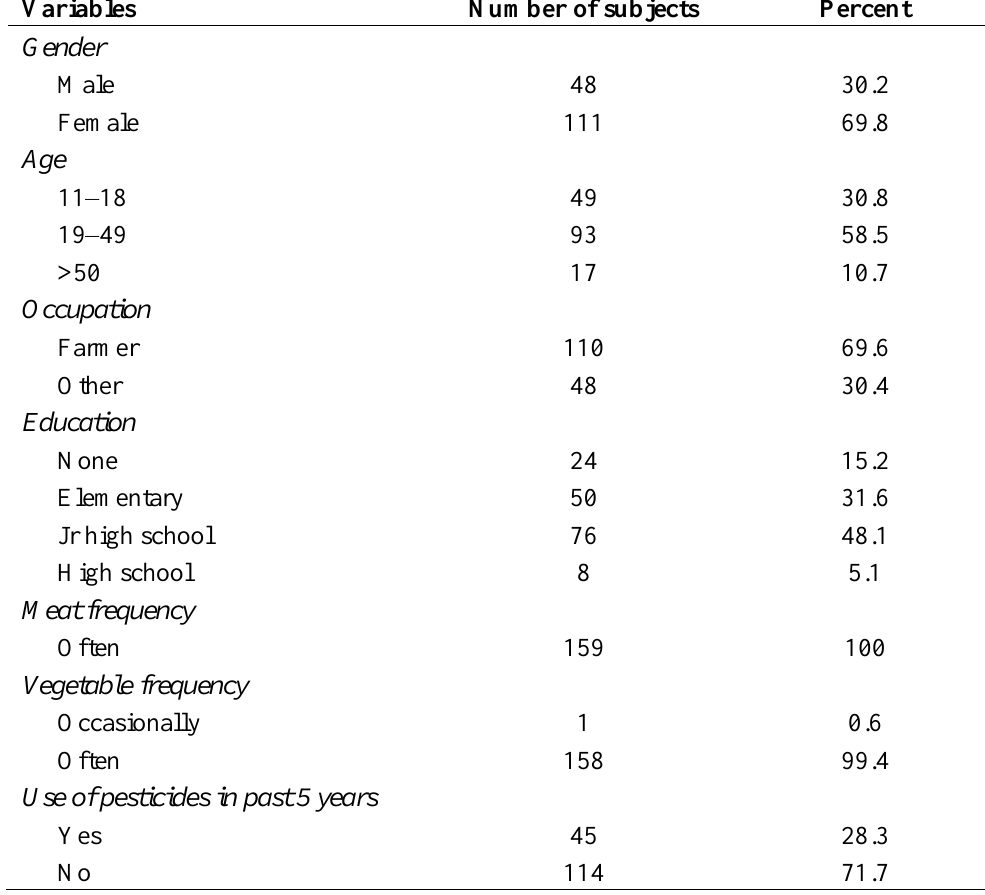
Table 2. Selected characteristics of study